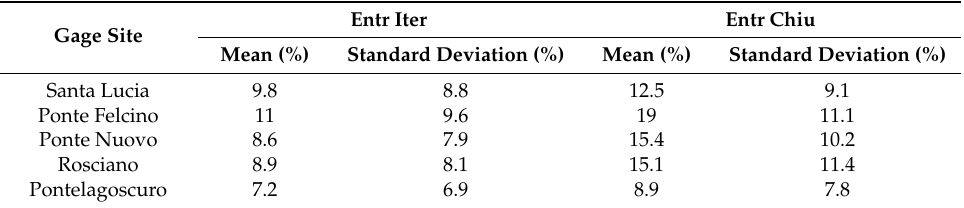
Table 2. Mean and standard deviation of the absolute percentage error in estimating the depth-averaged velocity using the dip assessment by the iterative procedure proposed here (Entr Iter) and Equation (7) (Entr Chiu) for the investigated gage sites.